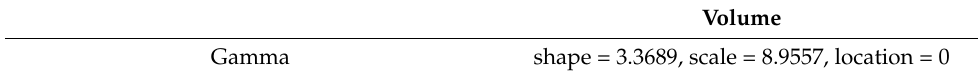
Table 7. MLEs of the model parameters for Volume.